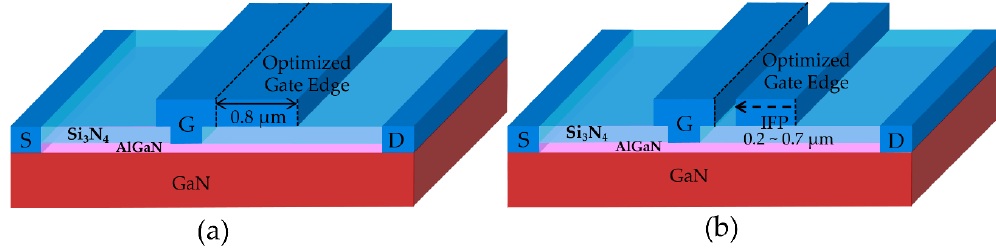
Figure 7. T-shaped gate AlGaN/GaN HEMT structure: ( a ) optimized FP structure; ( b ) schematic of inner field-plate (IFP) structure.